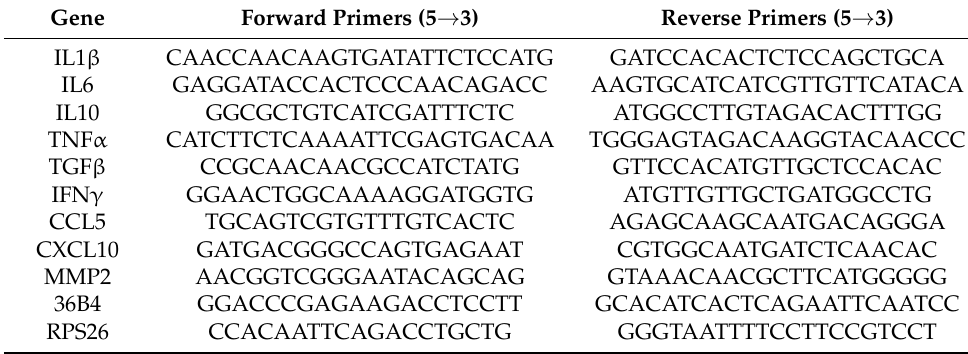
Table 1. Primers used for